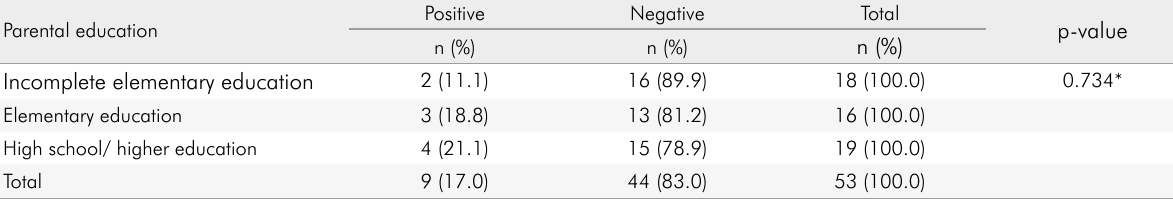
Table 6. Results of serological tests for COVID-19 and parental education Parental